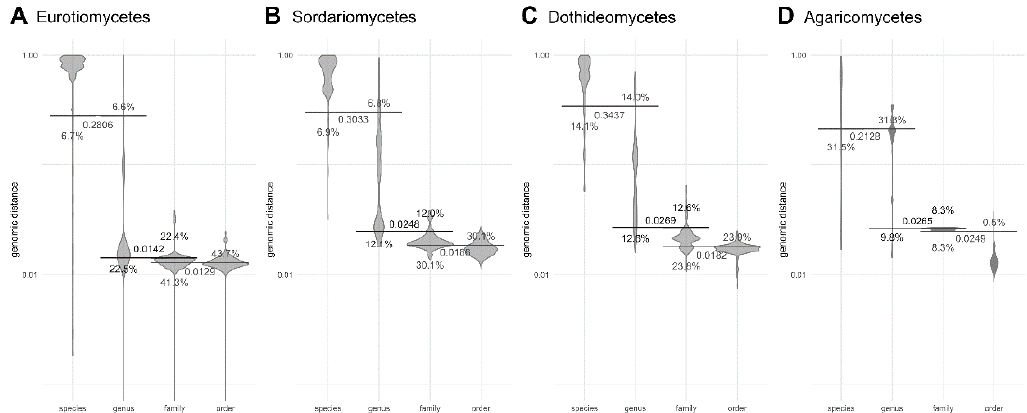
Figure 7. Genomic distances between pairs of fungal genomes at various taxonomic ranks within Eurotiomycetes ( A ), Sordariomycetes ( B ), Dothideomycetes ( C ), and Agaricomycetes ( D ), calculated by Dashing with k-mer size 16. Horizontal lines crossing pairs of taxonomic ranks show the best division lines between the ranks, calculated to minimize the share of genomic distances on the wrong side of the line (misclassified distances). Numbers next to the line mark the y -axis intercept (the genomic distance threshold), percent show the proportion of misclassified distances by horizontal line closest to them. The y -axis is logarithmic.